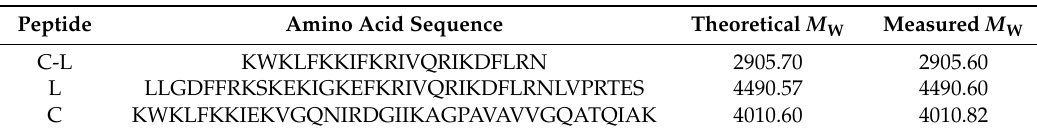
Table 1. Amino acid sequence and molecular weight ( M W ) of C-L, L, and C determined by Matrix-assisted laser desorption ionization (MALDI) mass spectrometry.